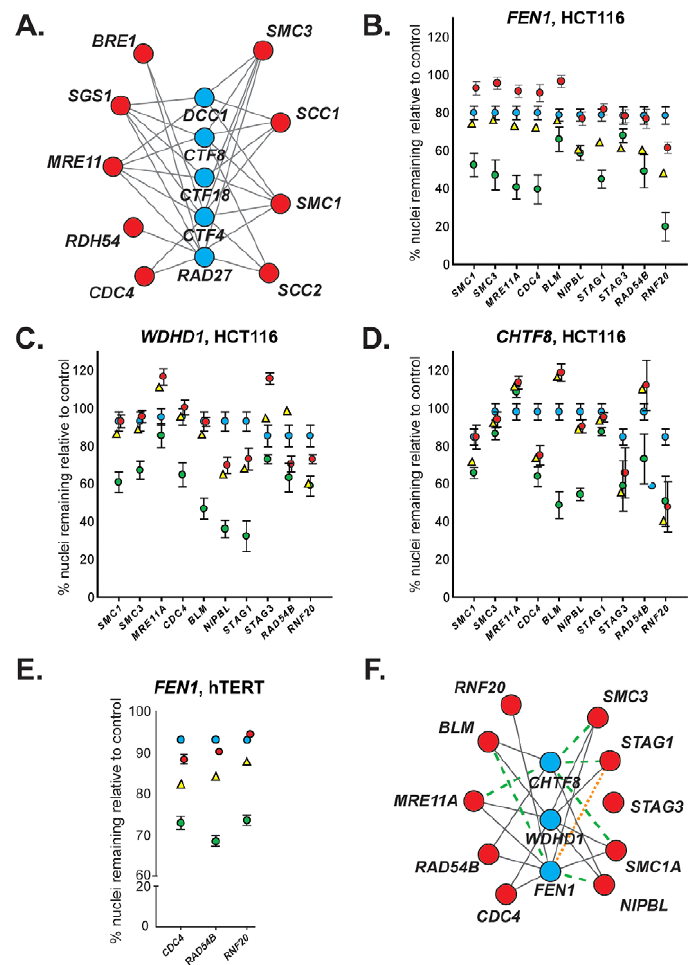
Figure 1. Evolutionary conservation of synthetic lethal interactions in HCT116 cells. (A) A yeast cancer-ortholog synthetic lethal network. Lines indicate synthetic lethal genetic interactions. Yeast genes and human orthologs are presented in Table 1. Red circles represent S. cerevisiae orthologs of genes mutated in cancer; blue circles indicate common interacting partners, which are referred to as ‘‘central’’ genes. (B–D) Representative data depicting mean percentage of remaining HCT116 cells ( 6 SEM) treated with pooled siRNAs targeting central genes (top) and cancer genes (along x -axis) relative to GAPDH-silenced controls. Blue circles, siRNA targeting central gene alone. Red circles, siRNA targeting cancer gene alone. Yellow triangles, predicted viability of double siRNA treatment. Green circles, observed viability of double siRNA treatment. For raw data, please refer to Table S1. GAPDH siRNA does not significantly reduce viability relative to a non-silencing siRNA (Figure S2A). (E) Representative data depicting mean percentage viability of hTERT cells ( 6 SEM) treated with pooled siRNAs targeting FEN1 and cancer genes (along x -axis) relative to GAPDH-silenced controls. Symbols are as in B. (F) Mammalian genetic interaction network. Solid grey line, interaction observed in both S. cerevisiae and HCT116 cells; green dashed line, interaction observed only in S. cerevisiae ; orange dotted line, interaction observed only in HCT116 cells.